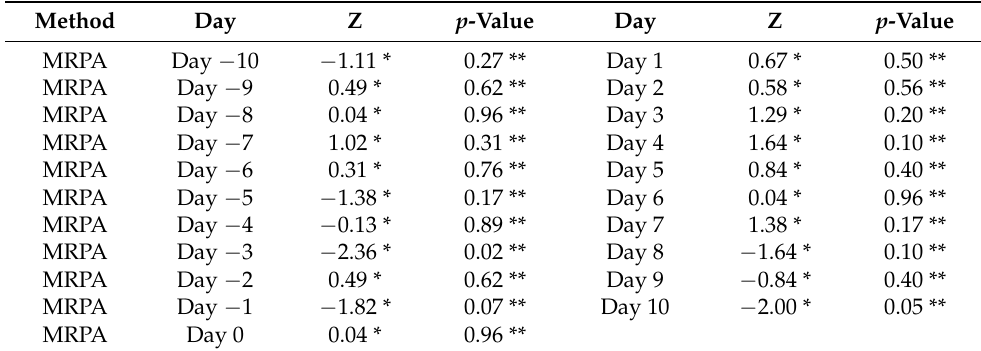
Table 6. Wilcoxon signed-rank test, MRPA method. Method